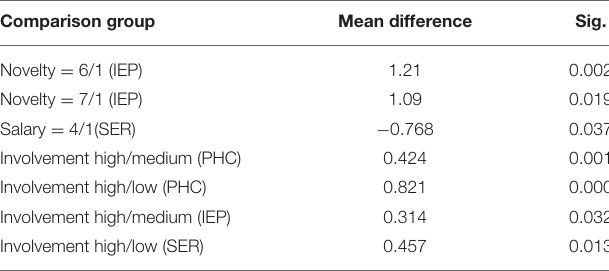
TABLE 6 | Post-hoc comparison between different groups for constraints